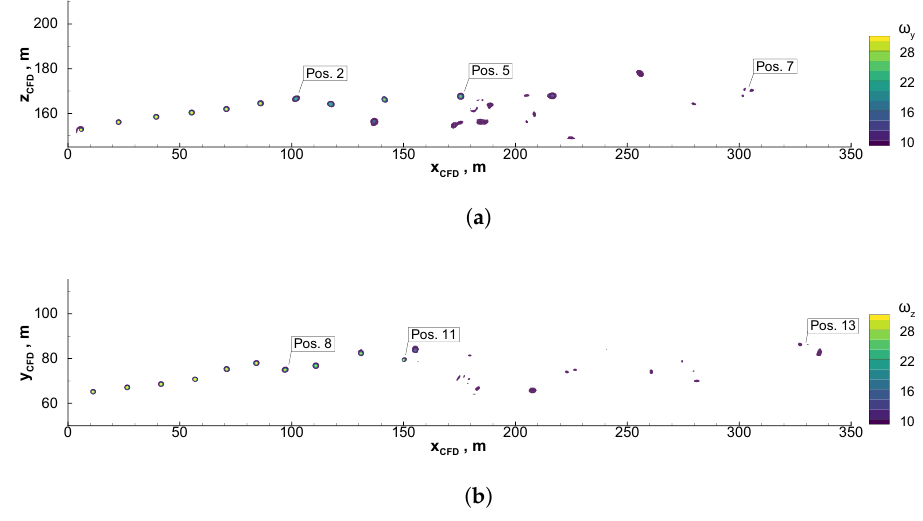
Figure 8. Vortex merging in WT wake flow field C1, (OS-1). ( a ) Vorticity ω y in a vertical plane passing through the rotor plane at y CFD = 0m. ( b ) Vorticity ω z in a horizontal plane at z HUB =